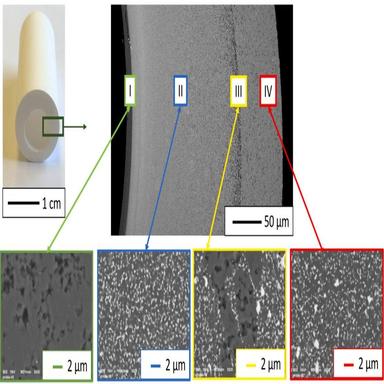
Sample SEM microphotographs of a composite with 40 vol.%of solid phase in the casting slip used for centrifugal slip casting of the samples.